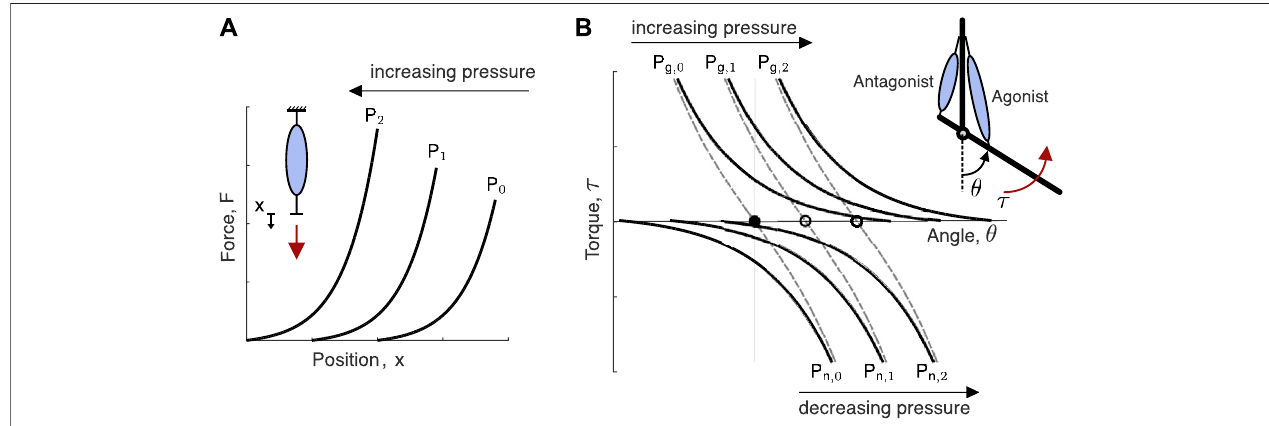
FIGURE 2 | Conceptual overview of the equilibrium-point hypothesis applied to soft pneumatic actuators. (A) Idealized force-de fl ection curves for three different nominal internal pressures of a contraction-type soft actuator. Nominal pressure refers to the internal pressure before the external load is applied, which invariably changes the internal pressure do to volume changes. As the nominal pressure of the actuator is increased, the force-de fl ection curve is shifted. (B) Idealized force- de fl ection curves for antagonistically con fi gured contraction-type soft pneumatic actuator for three different nominal internal pressures demonstrate a shift in the equilibrium position of the joint, while the net force-de fl ection curve (dashed traces) is maintained constant. The depicted shift in equilibrium occurs by increasing the agonist actuator ’ s internal pressure ( P g ,0 < P g ,1 < P g ,2 ) and decreasing the antagonist actuator ’ s internal pressure ( P g ,0 > P g ,1 > P g ,2 ).